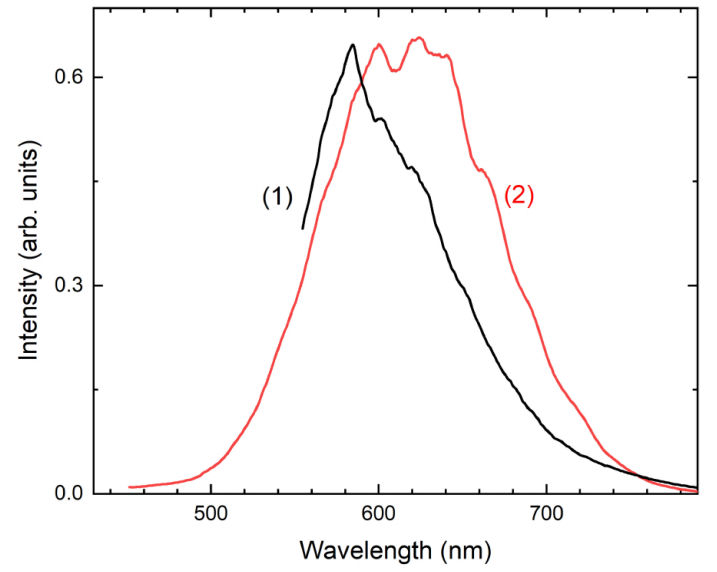
Figure 24. Emission spectra of marinellite (1) and biachellaite (2) upon excitation by radiation with a wavelength of 405 nm.